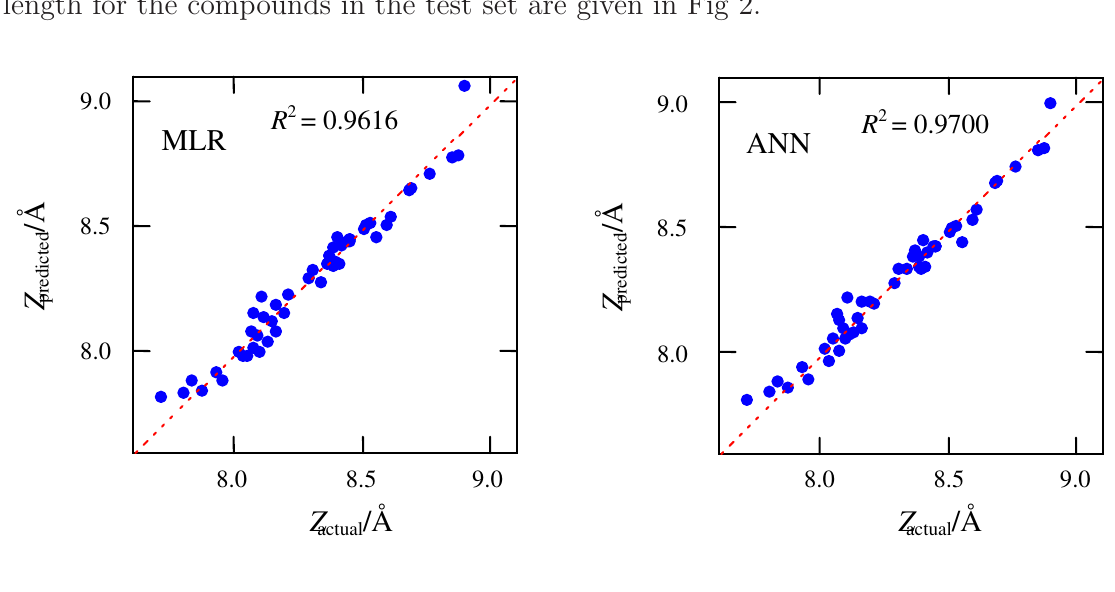
Fig. 2 Correlation between actual and predicted values for a by MLR and